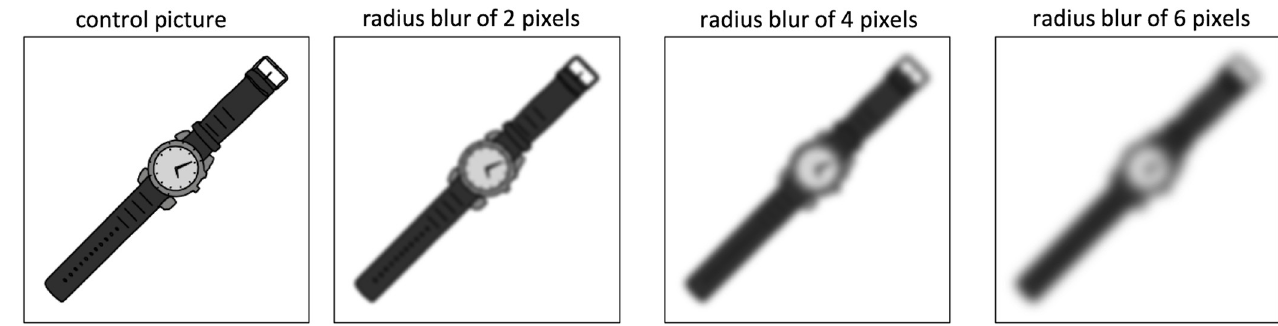
Fig 2. Example of each condition used for the preliminary